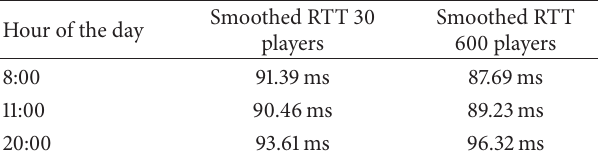
Table 7: Average smoothed RTT of all the MMORPG